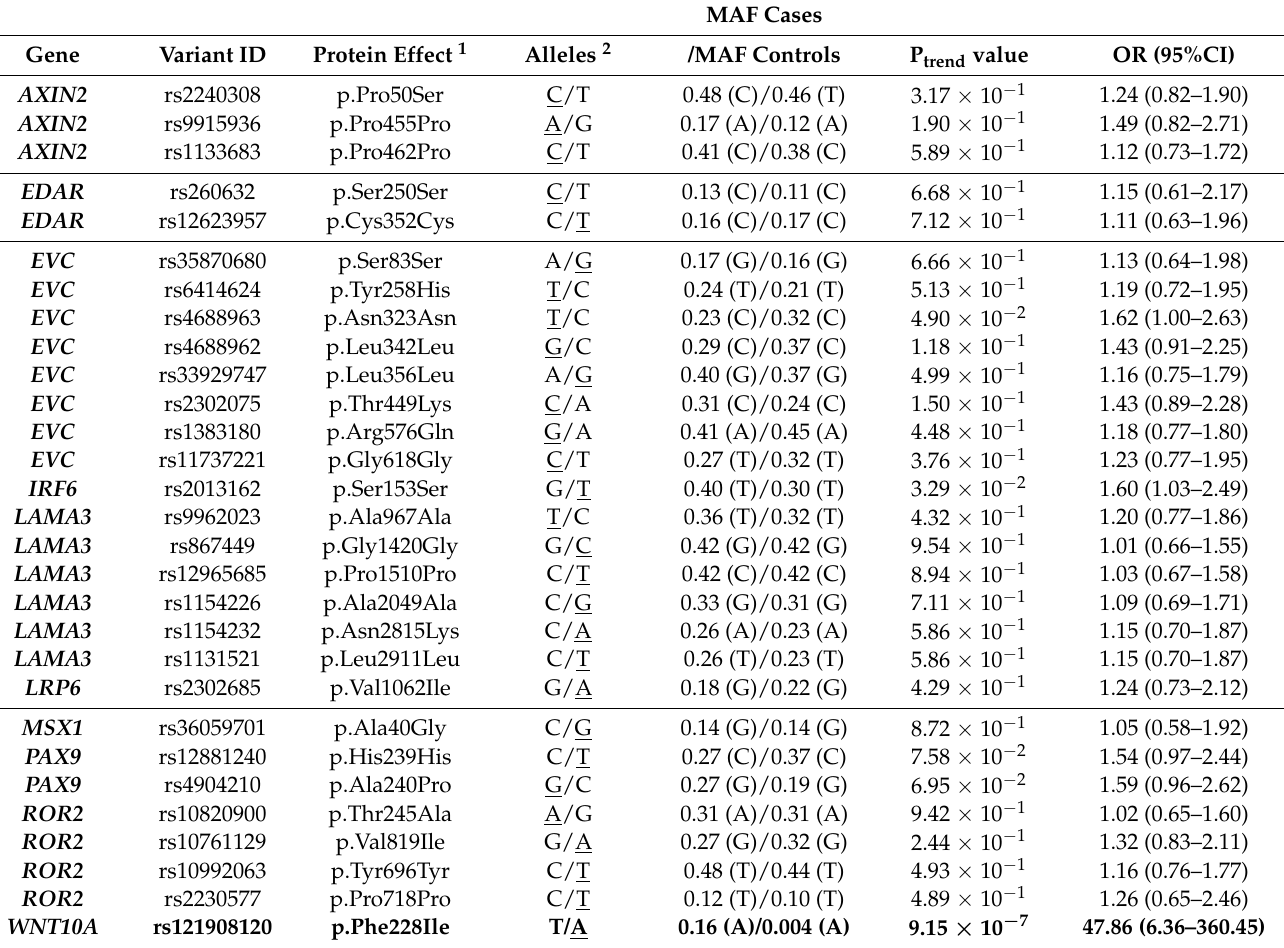
Table 5. Association of common exonic variants with the risk of